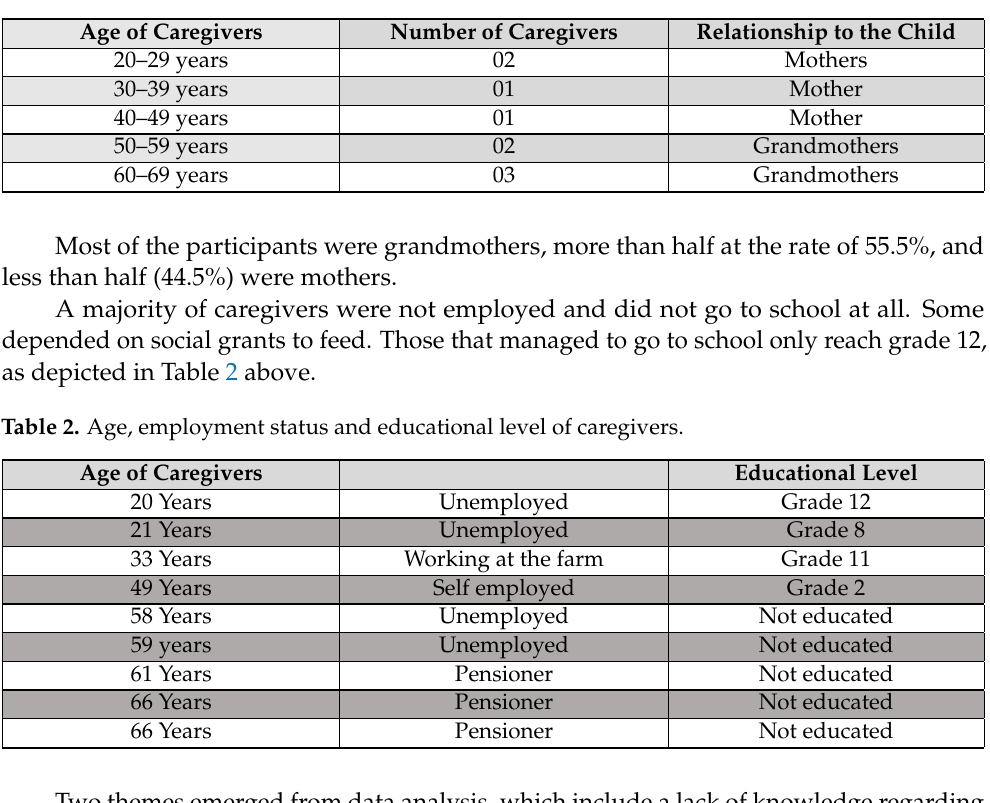
Table 1. Age of Caregivers.